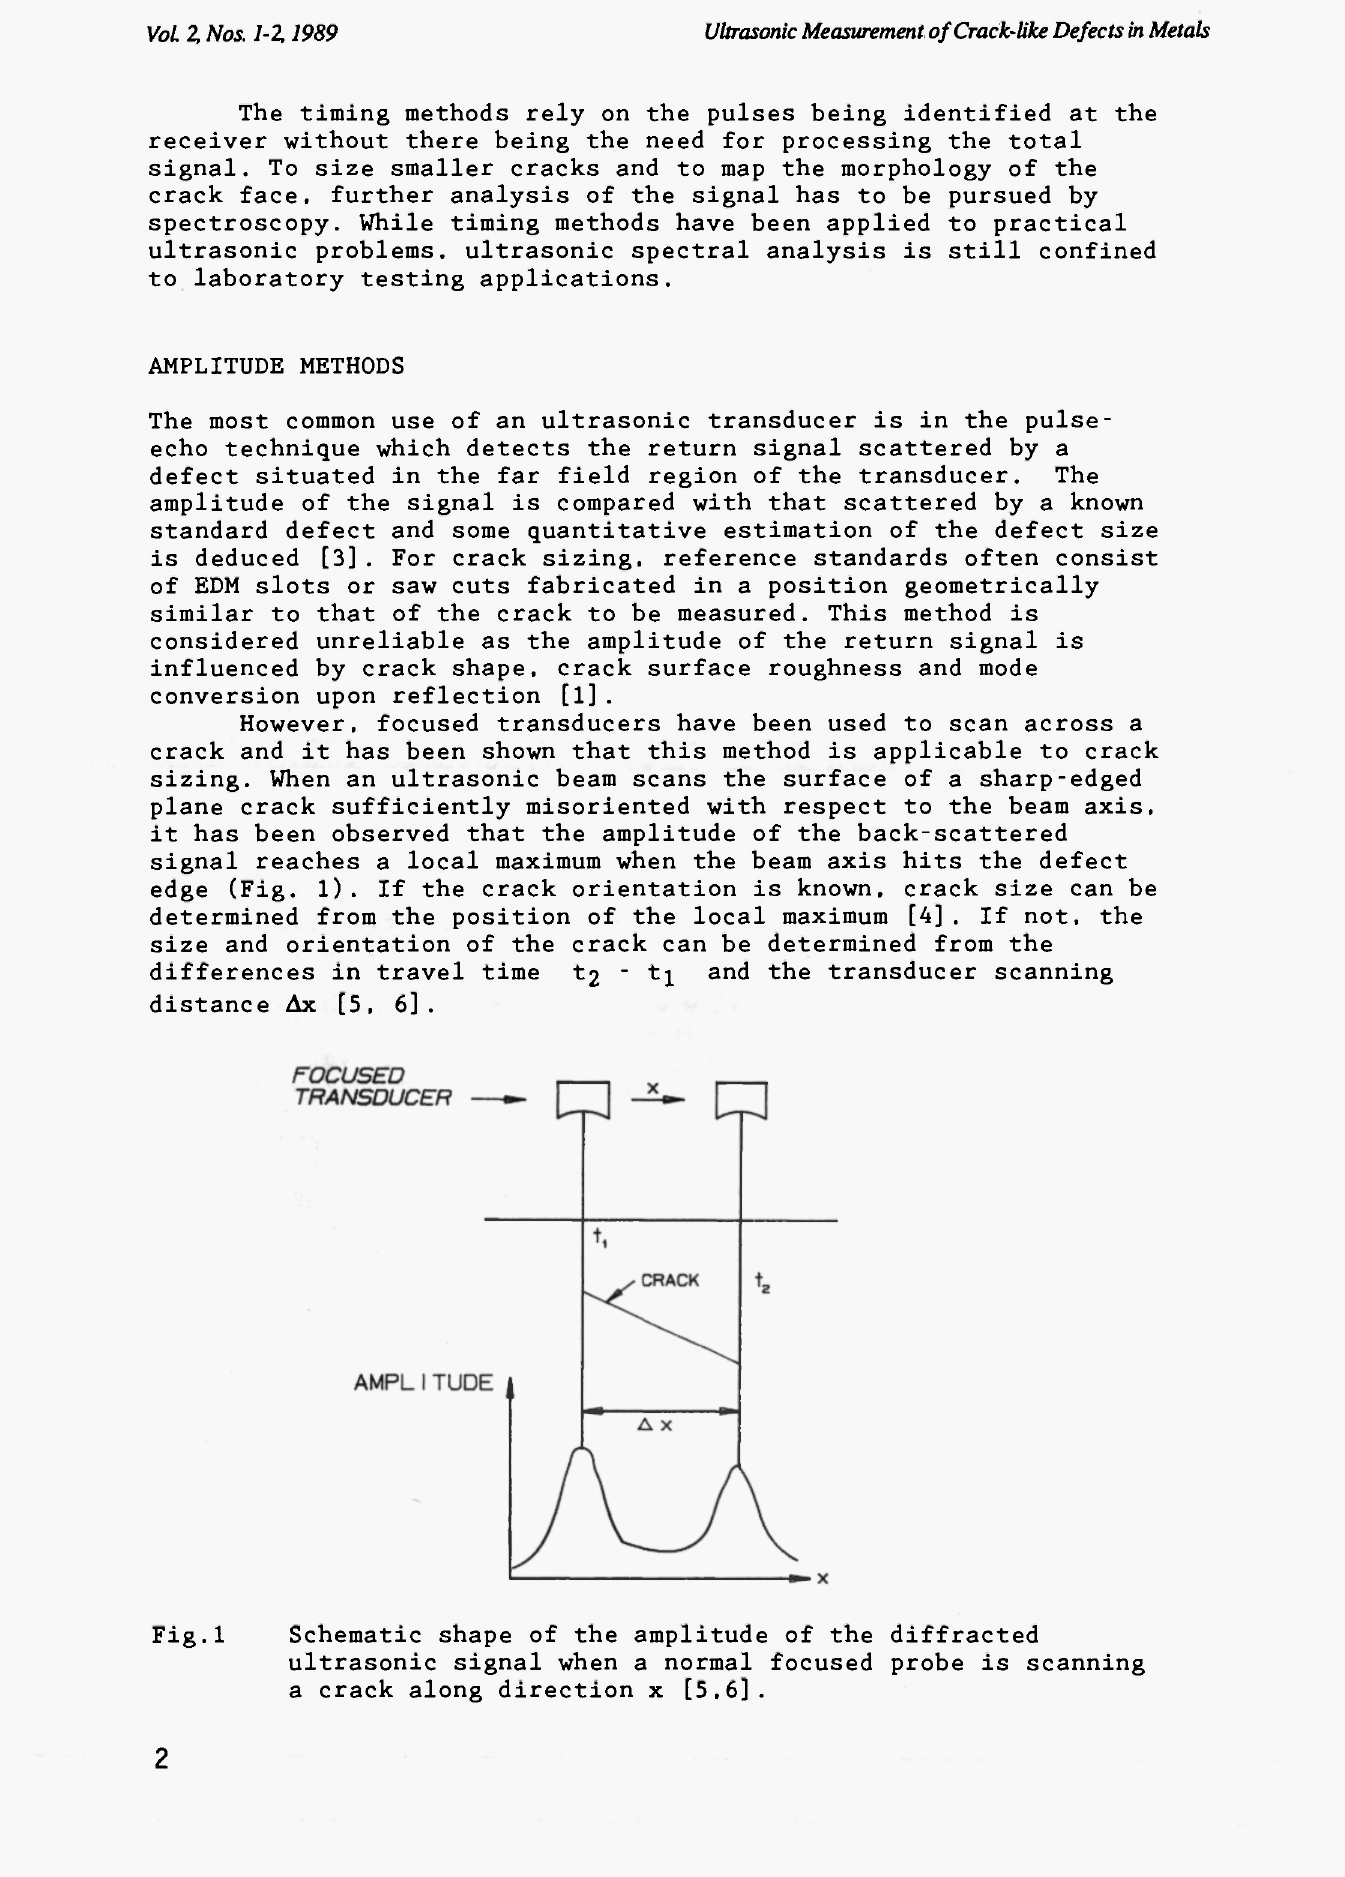
Fig.l Schematic shape of the amplitude of the diffracted ultrasonic signal when a normal focused probe is scanning a crack along direction χ